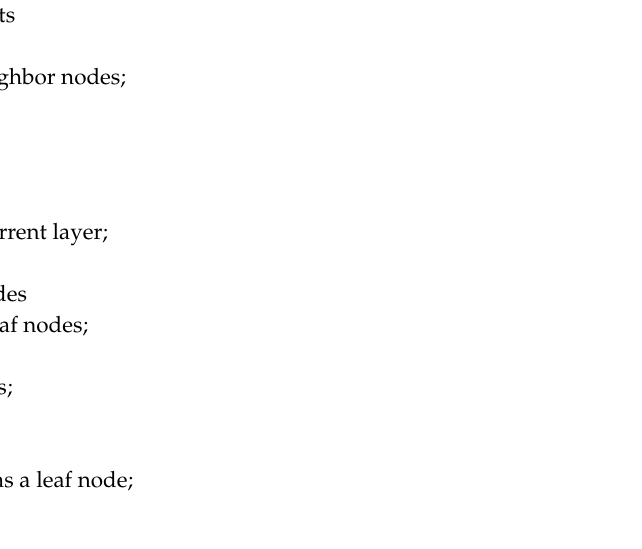
Algorithm 2. Spanning tree generation